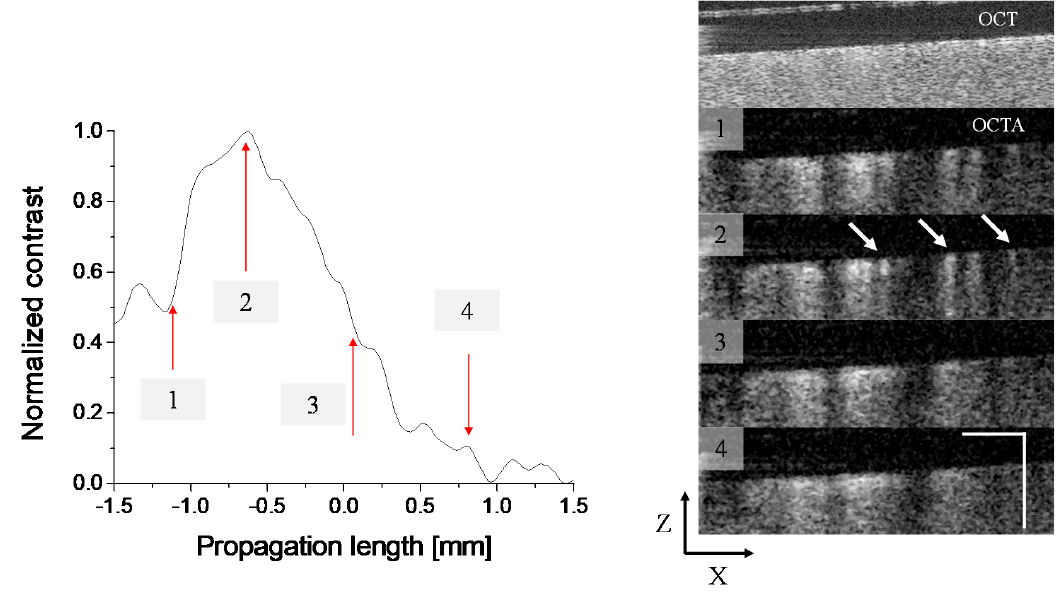
Figure 3. Contrast change of the digitally focused Images 1–4 as a function of the propagation length. Image 2 in the graph shows the highest contrast. White arrows indicate clear flow signals. Scale bar is 500 µm.